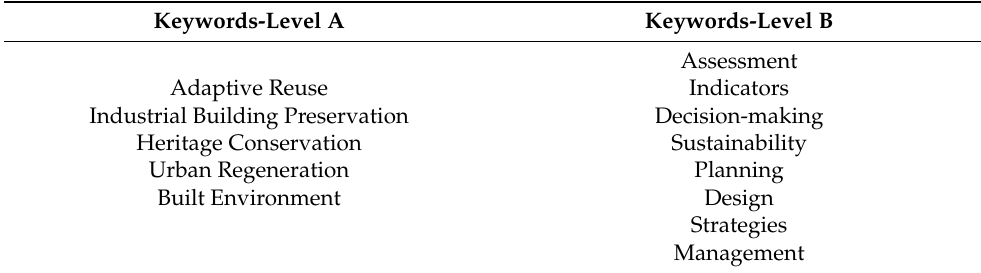
Table 1. Keywords used in literature review.